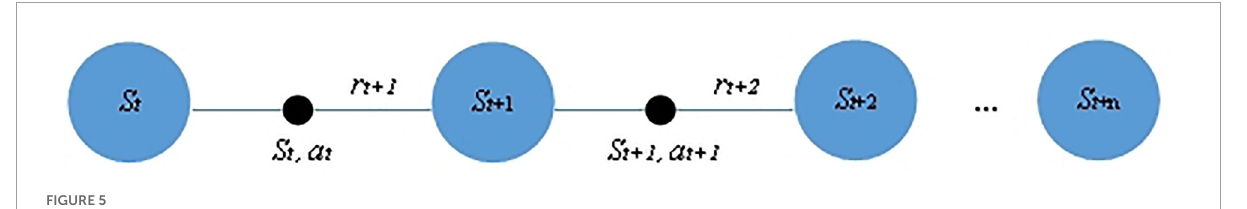
FIGURE5 The RL sequence of states and actions (Tripathi et al., 2018).